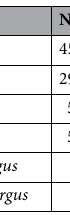
Table 1. Counts of lake Niphargus and olm co-occurrences by localities. Only co-occurrences in the exact same cave or spring are